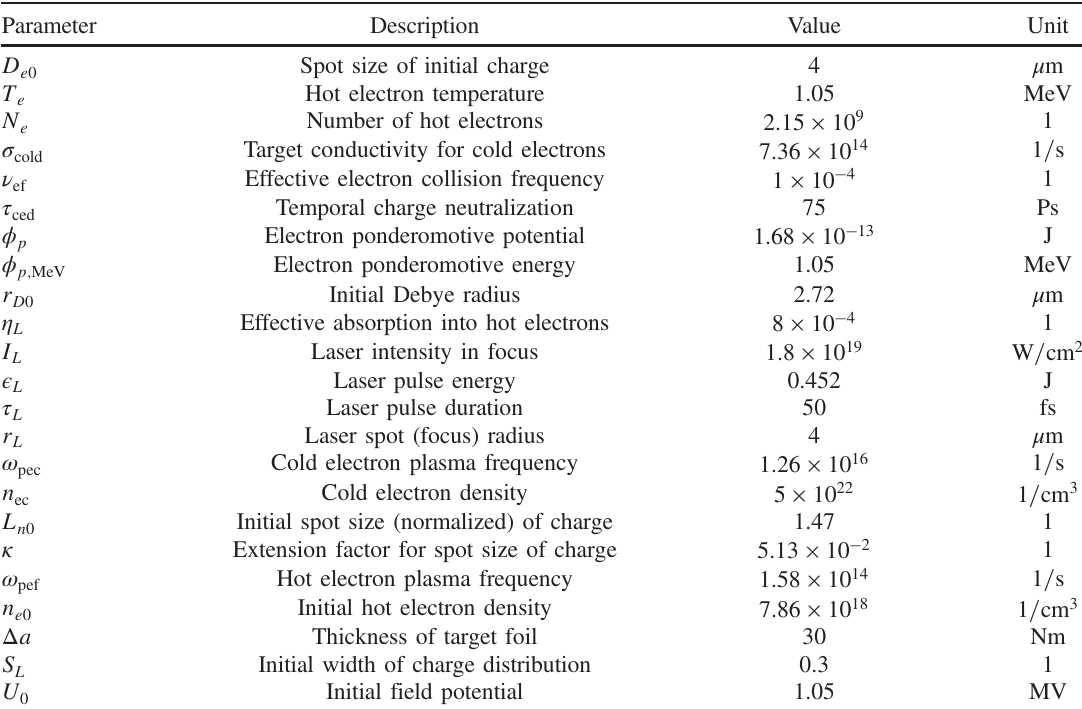
TABLE I. Variables and simulation parameters of model A and model